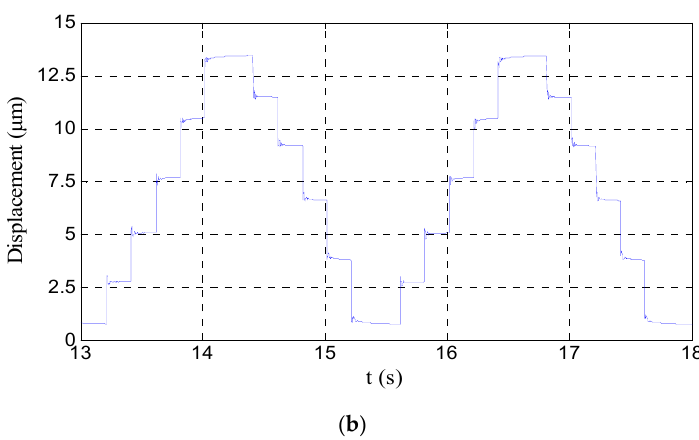
Figure 25. Measured input–output relationship of the mechanical stage: ( a ) the input voltage signal, and ( b ) the output displacement of the mechanical stage.